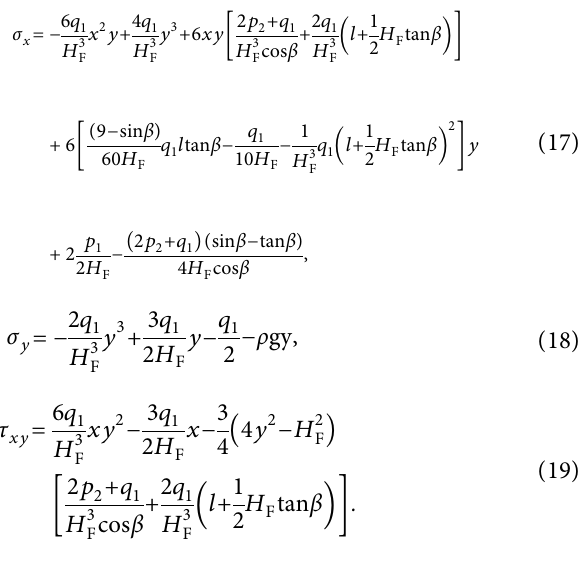
1 and P 2 on right